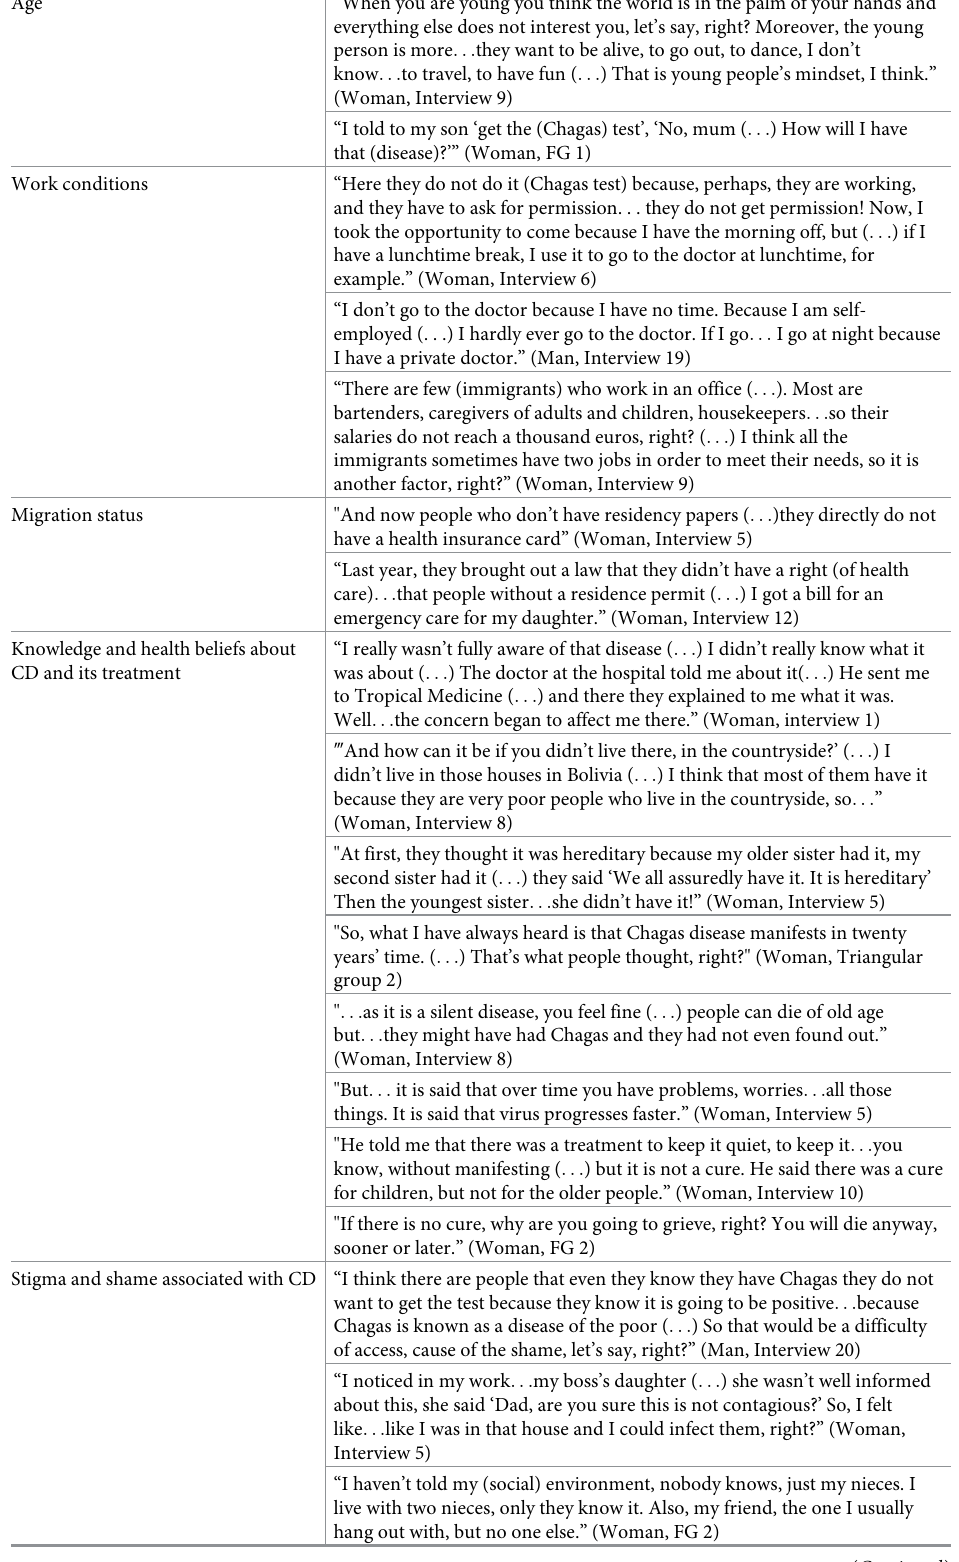
Table 5. Quotes related to predisposing